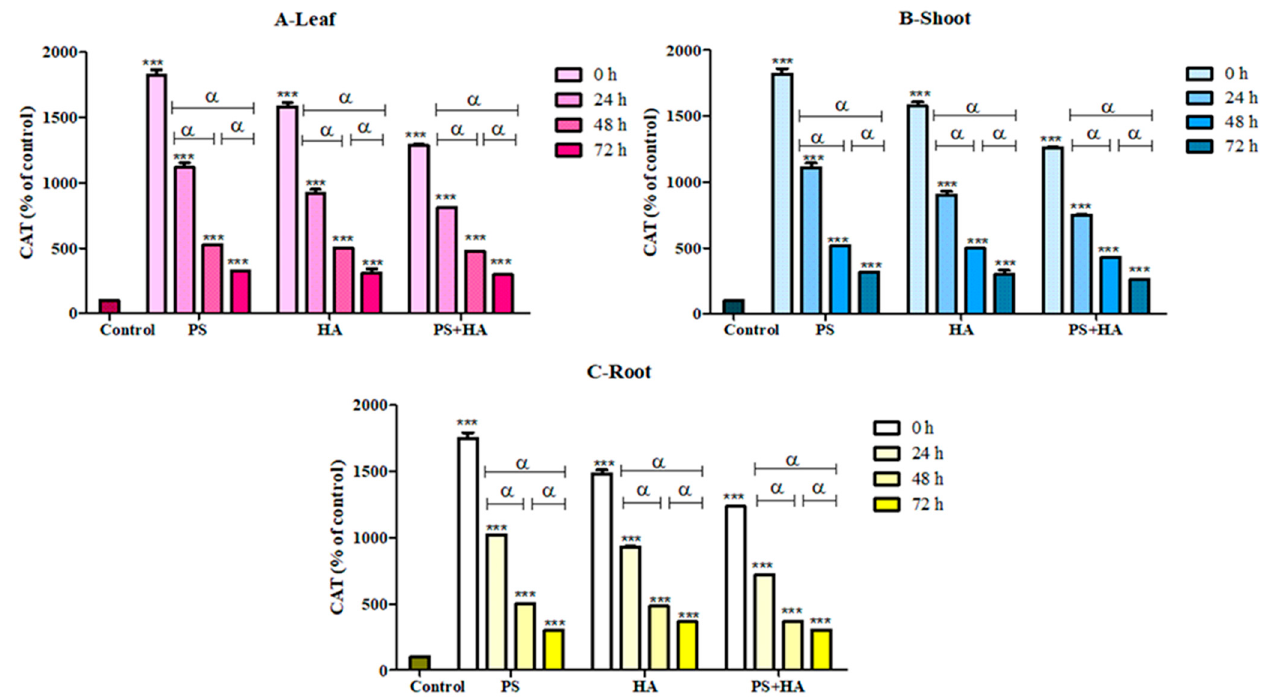
Figure 12. Percentage of Catalase values of PS, HA & PS + HA treated Solanum lycopersicum samples. Note: ‘ *** ’ indicates the percentage difference concerning the control, and ‘ α ’ indicates a significant difference ( α = p < 0.001).